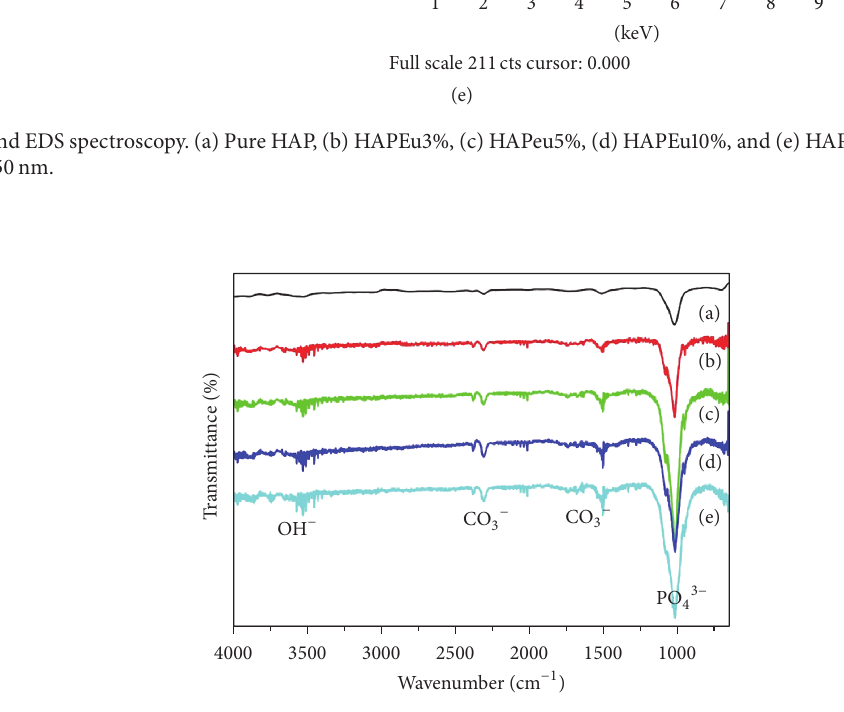
Figure 3: FTIR spectra of the samples prepared in this work. (a) HAPEu20%; (b) HAPEu10%; (c) HAPEu5%; (d) HAPEu3%; (e) HAP.